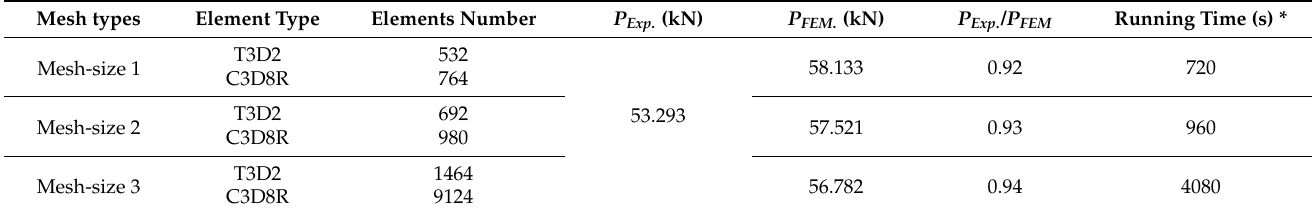
Table 7. Mesh convergence results.